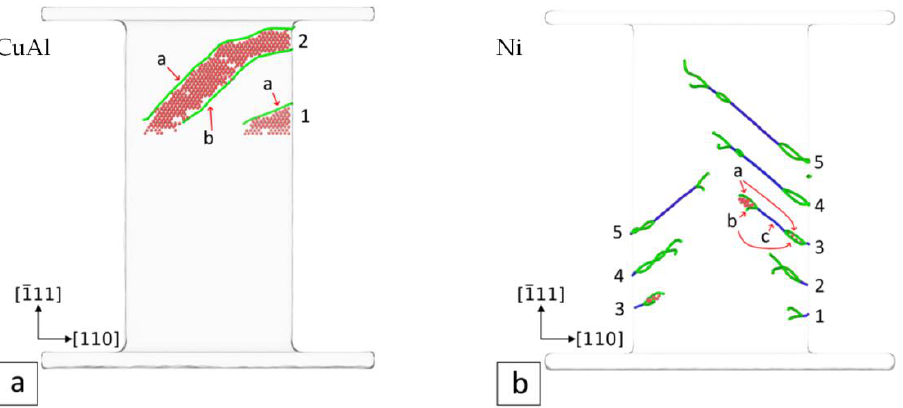
Figure 2. The kinematics of dislocations motion in ( a ) CuAl and ( b ) Ni at times 1, 2, 3, 4 and 5: a — screw partial dislocations, b — edge partial dislocations, and c — perfect dislocation.